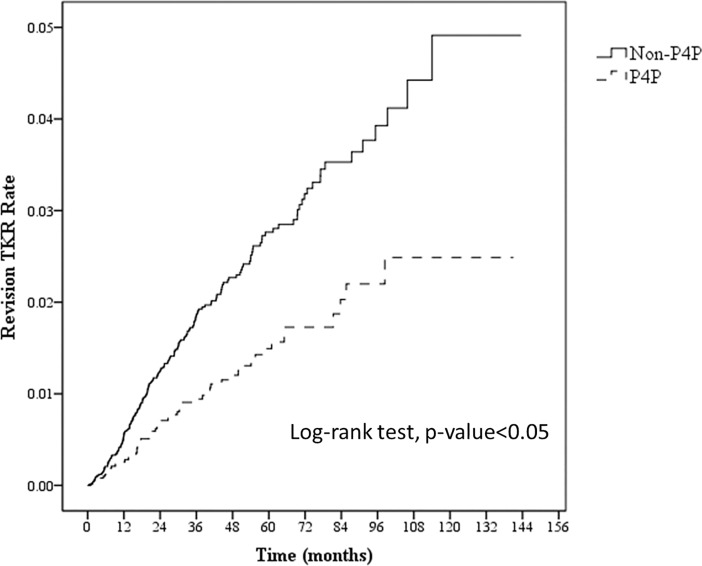
Cumulative risk curves of revision TKA for P4P and non-P4P patients.Joining the P4P program is associated with a tendency of significantly lowered risk (log-rank test; p < 0.05).